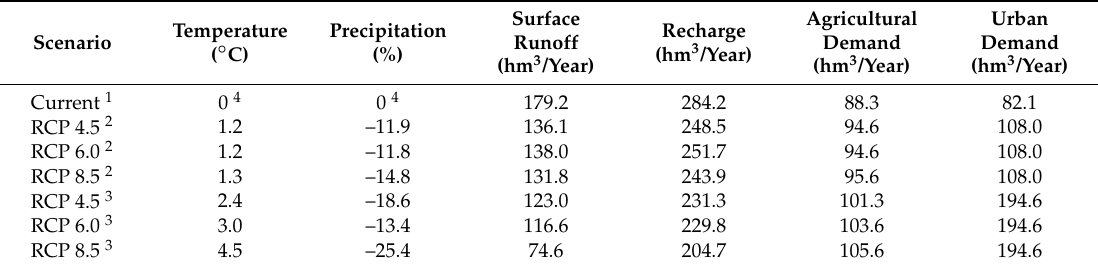
Table 5. Current and future simulated elements of the